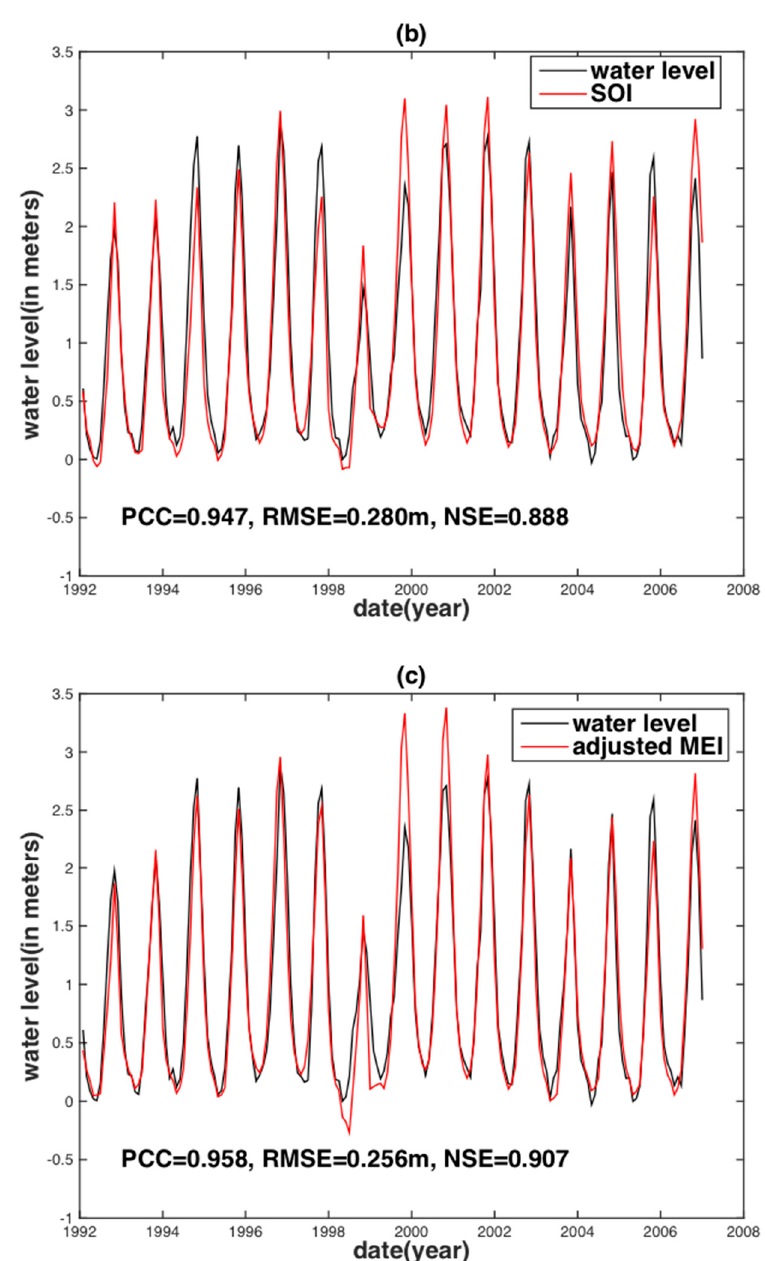
Figure 8. The water level reconstruction at the Vam Kenh station based on ENSO indices including negative SST anomalies in Niño 3.4 ( a ), SOI ( b ) and MEI ( c ).